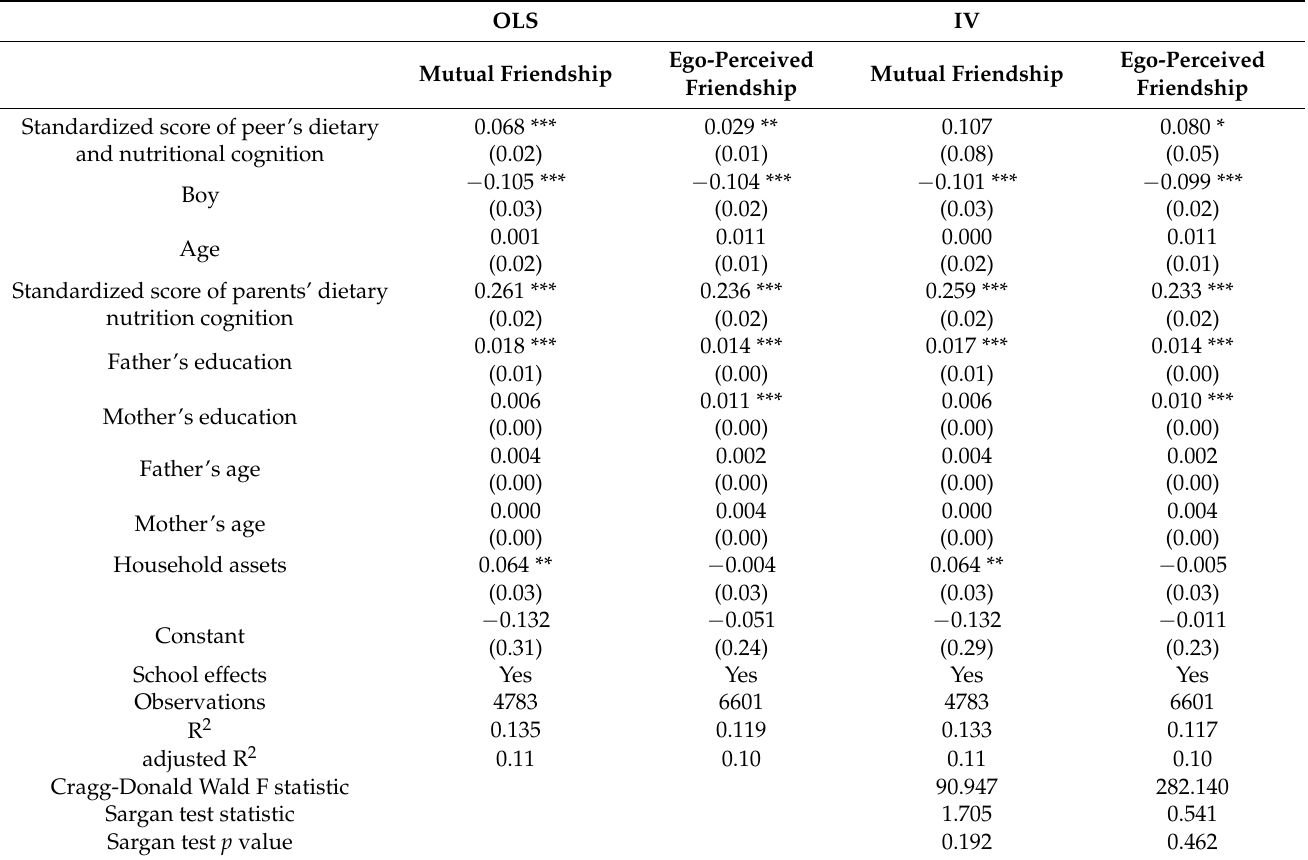
Table 5. Peer effect on the cognition of diet and nutrition for students with mutual friendship or ego-perceived friendship. OLS IV Ego-Perceived Ego-Perceived Mutual Friendship Mutual Friendship Friendship